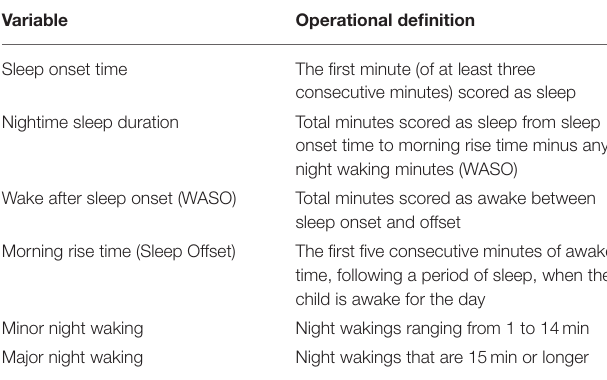
TABLE 1 | Sample demographic characteristics ( N = 30). TABLE 2 | Operational definitions of sleep